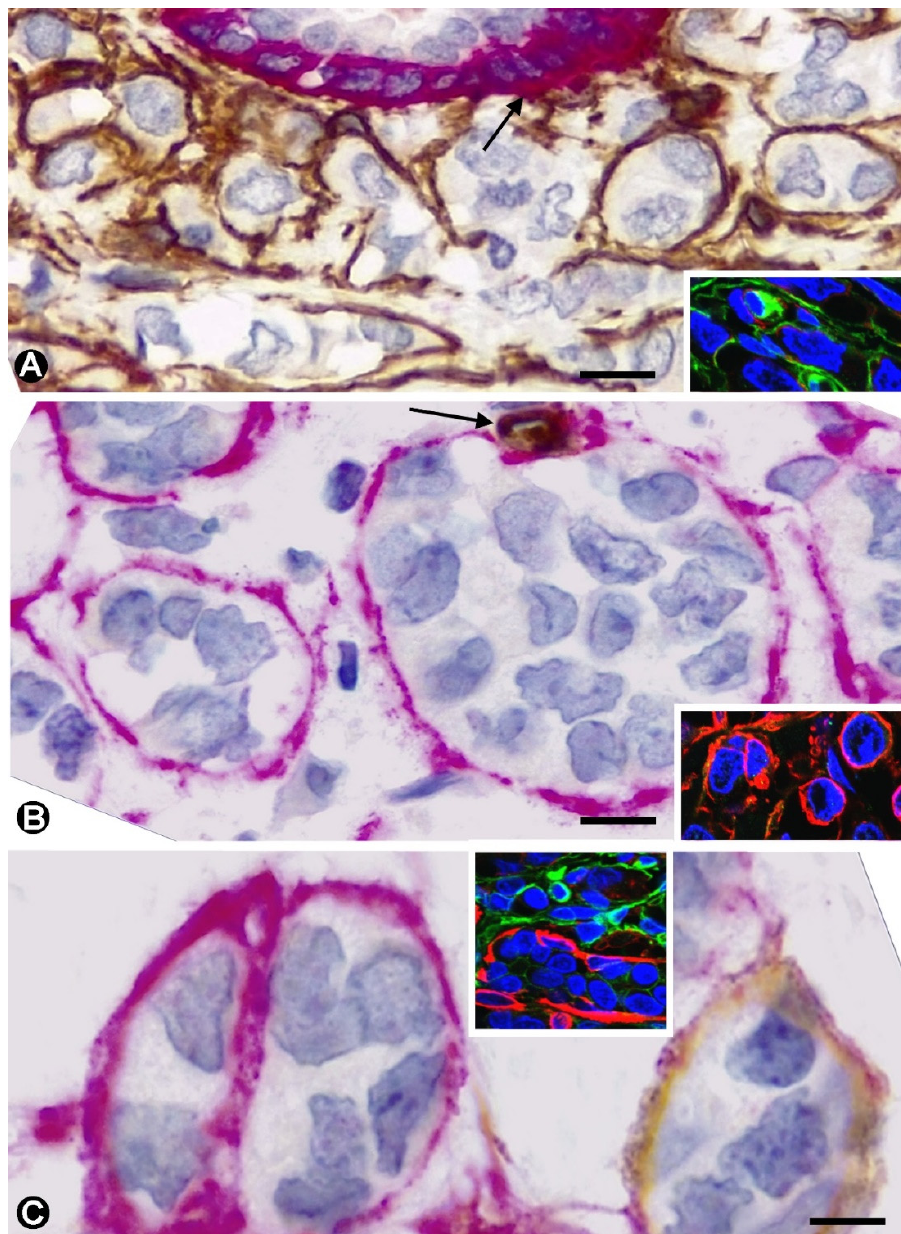
Figure 1. Stromal cells around nests of neoplastic cells in invasive lobular carcinoma of the breast. Double immunochemistry for CD34 (brown) and α SMA (red). Haematoxylin counterstain. Inserts: Double immunofluorescence labelling for CD34 (green) and α SMA (red) with DAPI (blue) counterstain. The stromal cells surrounding the neoplastic nests express CD34 (brown) in ( A ) and α SMA (red) in ( B ). In ( C ), the stromal cells express CD34 or α SMA, depending on the nest of neoplastic cells around which they are located. Note part of a duct in A, in which myoepithelial cells express α SMA (arrow). In B, a small vessel in which ECs express CD34 (arrow). The inserts show similar results by double immunofluorescence. Bar: ( A ): 15 µm; ( B ): 10 µm; ( C ): 8 µm. ECs, which also expressed CD34, showed more intense staining with this marker than stromal cells around the neoplastic cells (Figure 2A). α SMA+ mural cells (pericytes